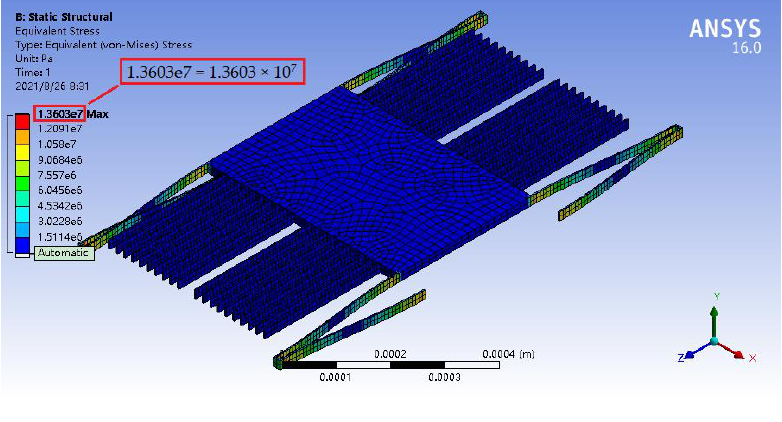
Figure 18. Stress nephogram of the micro-accelerometer under the acceleration of 100 g at 1200 °C.